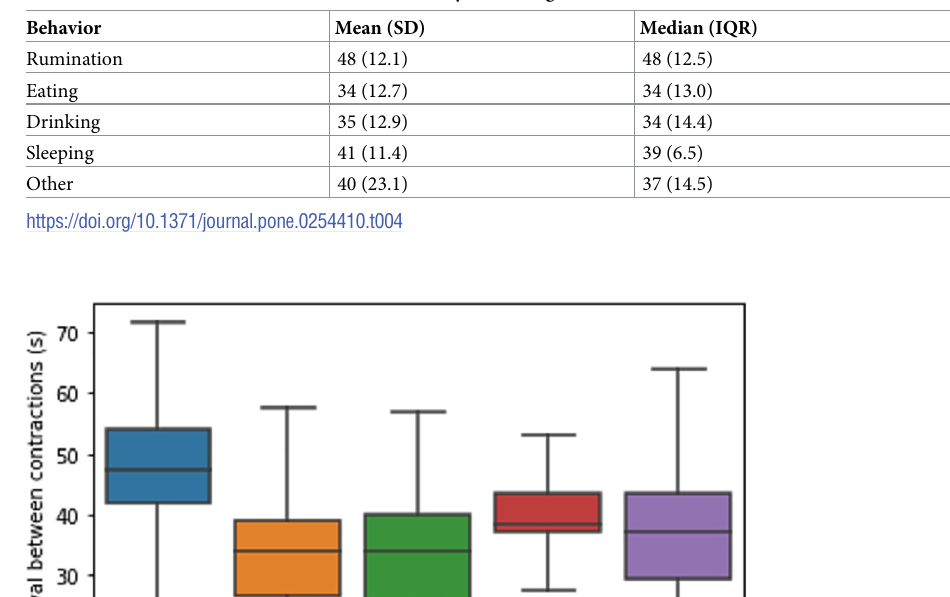
Table 4. Time in seconds between two contraction cycles during different cow behaviors.